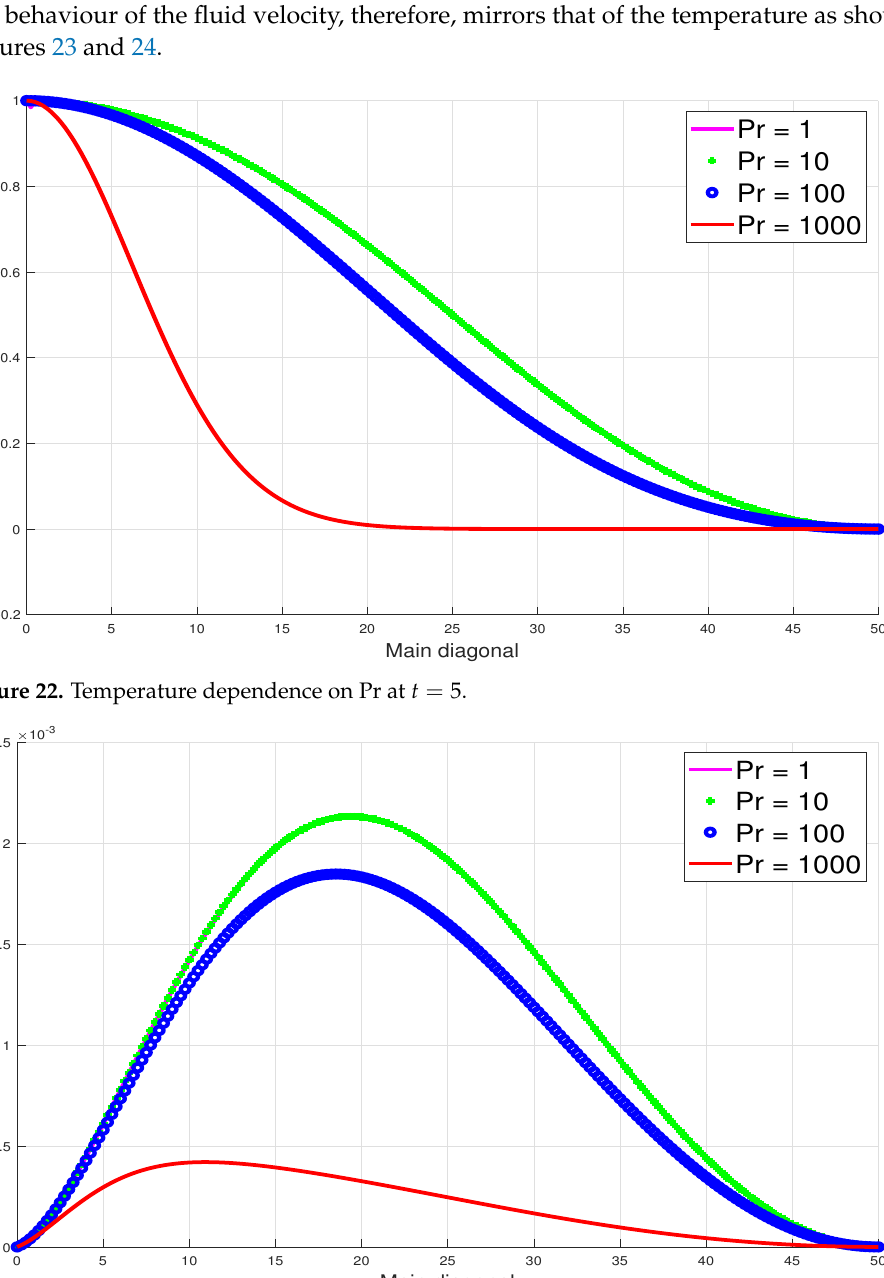
Figure 23. Axial velocity dependence on Pr at t =